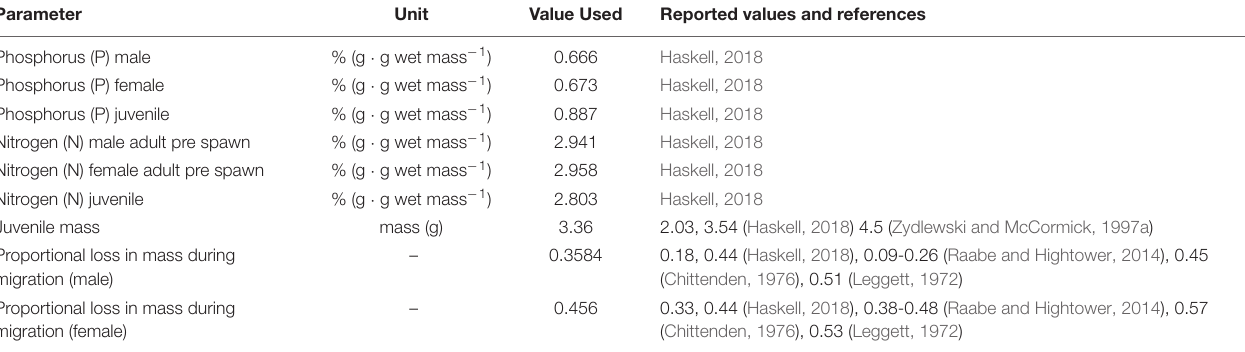
TABLE 2 | Parameter used to estimate annual, river specific nutrient input (via adult carcasses, spawning, and metabolism) and nutrient output (juvenile emigration). Parameter